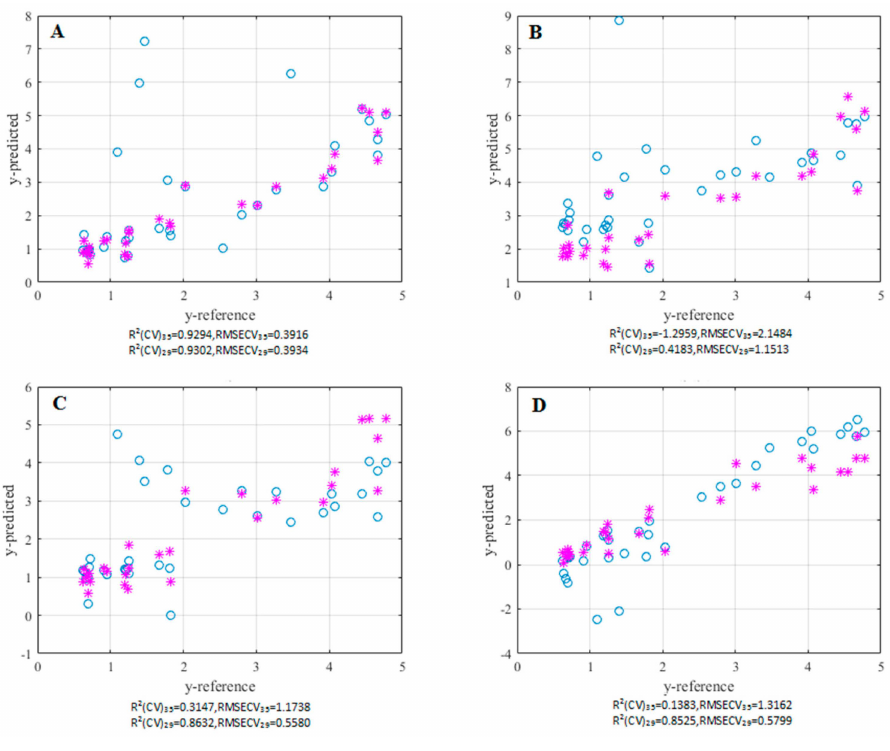
Figure 3. Comparison of the prediction performances of all four methods ( A ) RPLS; ( B ) MLR; ( C ) PLS; ( D ) LS-SVM. Here, (cid:13) represents before excluding outliers, ˚ represents after excluding